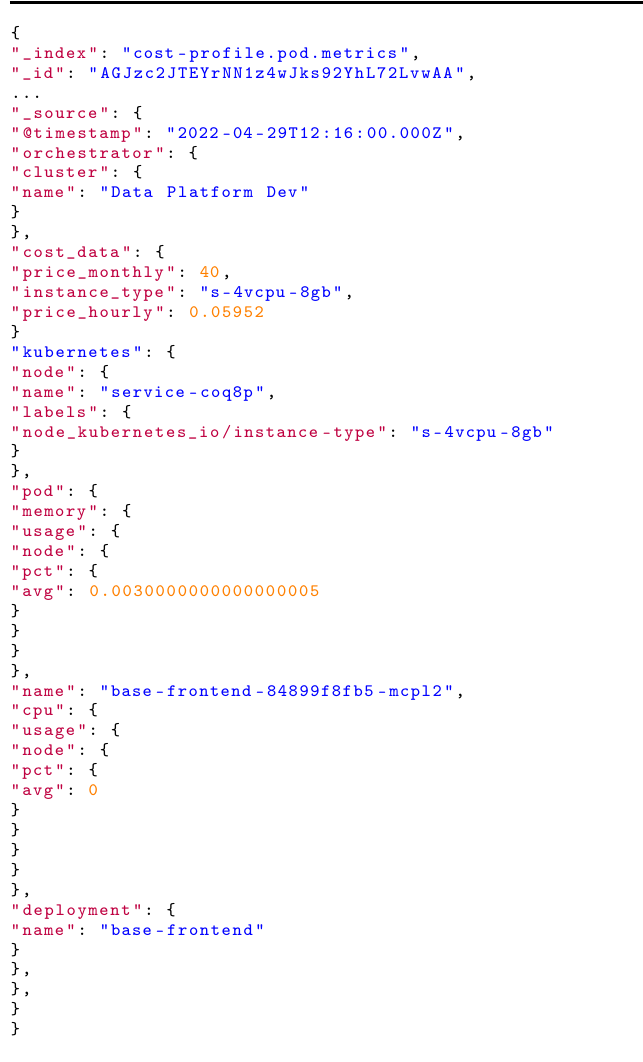
Listing 2. Example of the cost profile index for each pod.